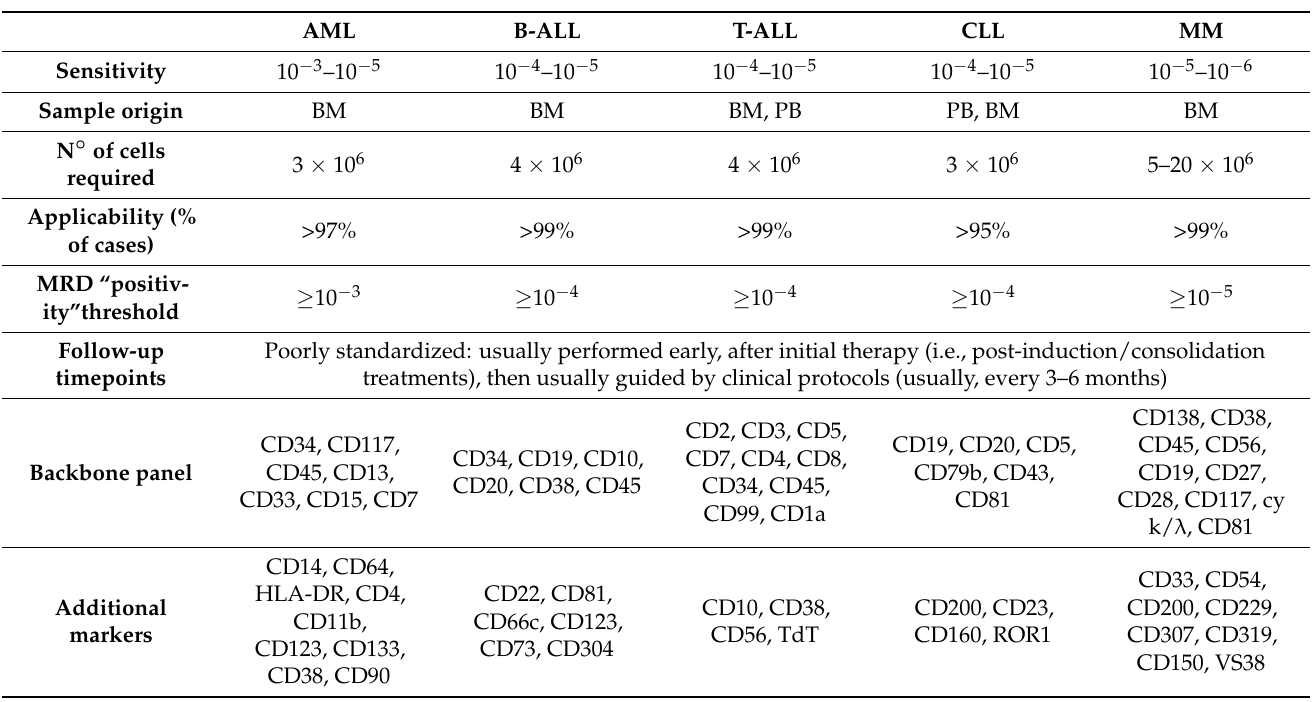
Table 1. Main features of MFC-based MRD monitoring in acute leukemias, CLL and